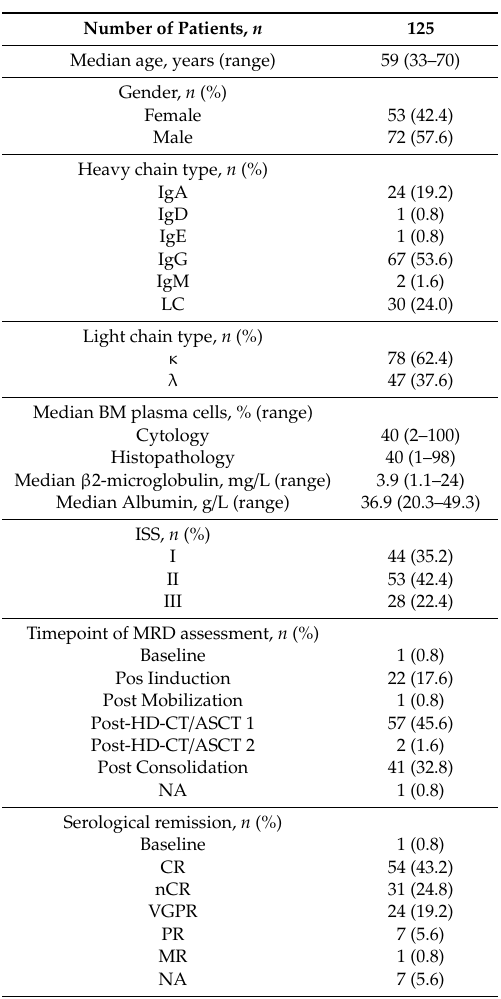
Table 1. Patient characteristics at first diagnosis, timepoints of MRD assessment and serological